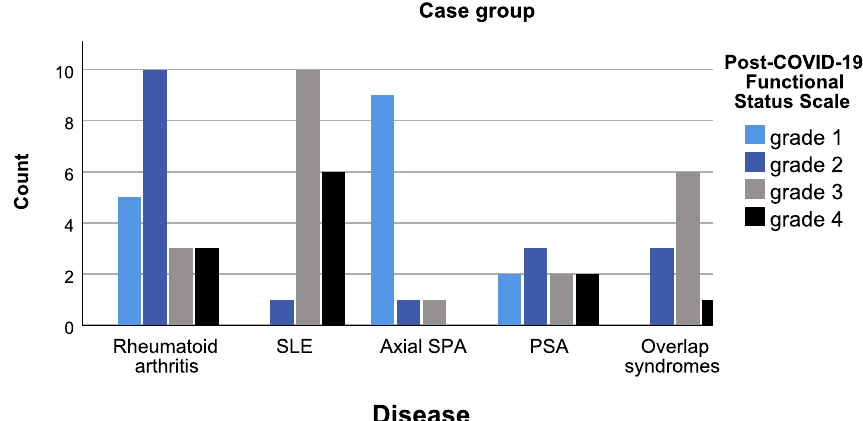
Fig. 1 Systemic lupus erythematosus (SLE) patients showed higher grades of functional disability in post-coronavirus disease 2019 (COVID-19) functional status scale (PCFS) than other rheumatic